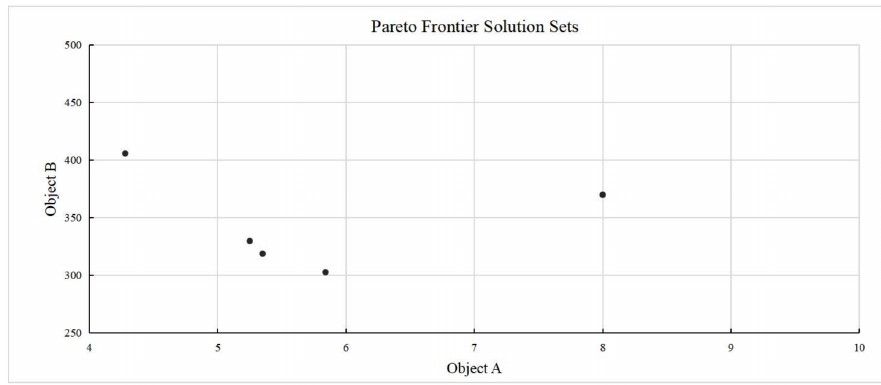
Figure 3. Pareto frontier solution set.